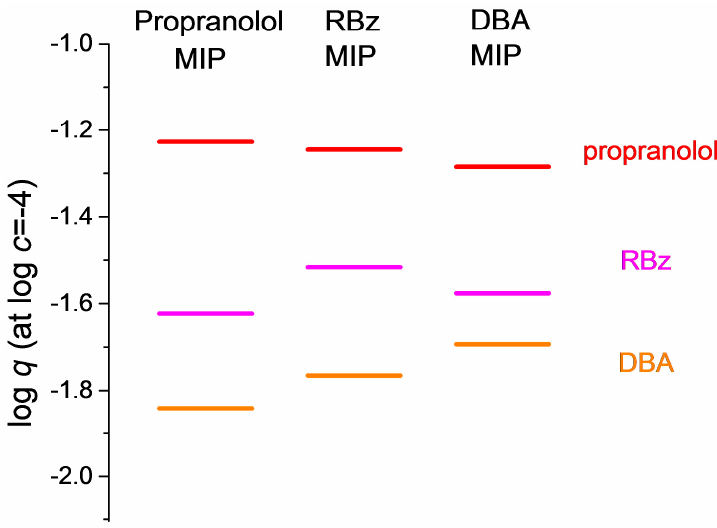
Figure 3. The effect of imprinting on three different amine MIPs. Adsorption of each compound was measured on all three polymers. All solutions were made in acetonitrile.